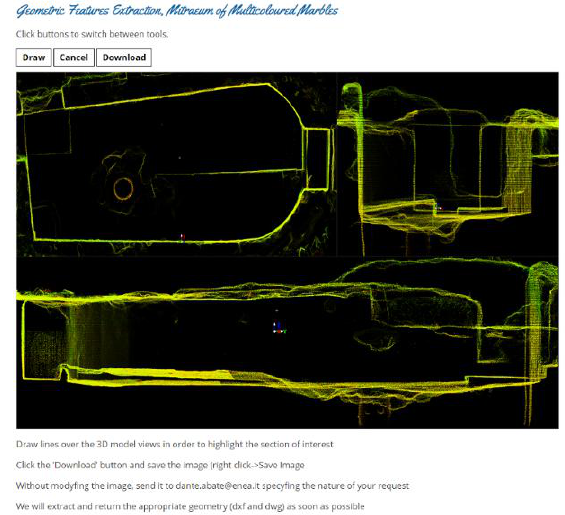
Fig. 12. Drawable